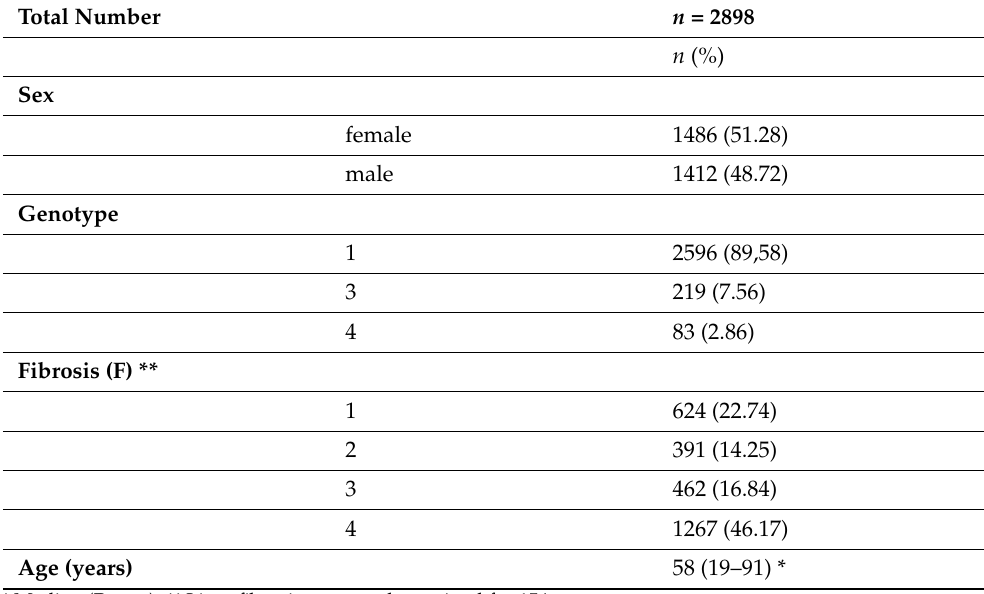
Table 1. The characteristics of the study